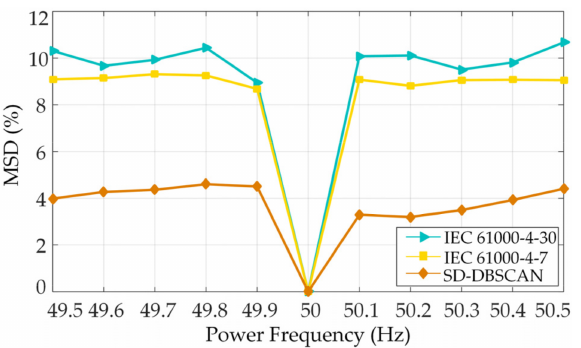
Figure 8. Results of the mean spectral difference (MSD) for different methods at varying power fre-